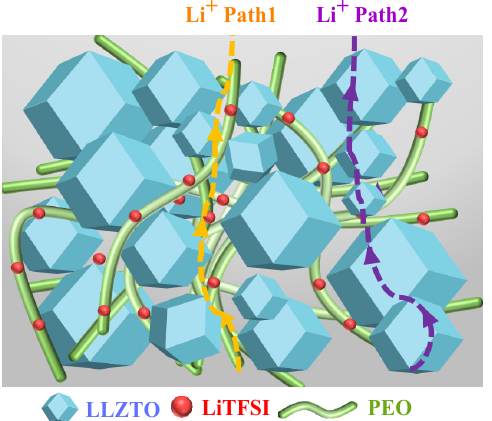
Figure 6. Schematic illustration of Li + transport mechanism in the cold-sintered LLZTO-PEO x -LiTFSI composite electrolytes.